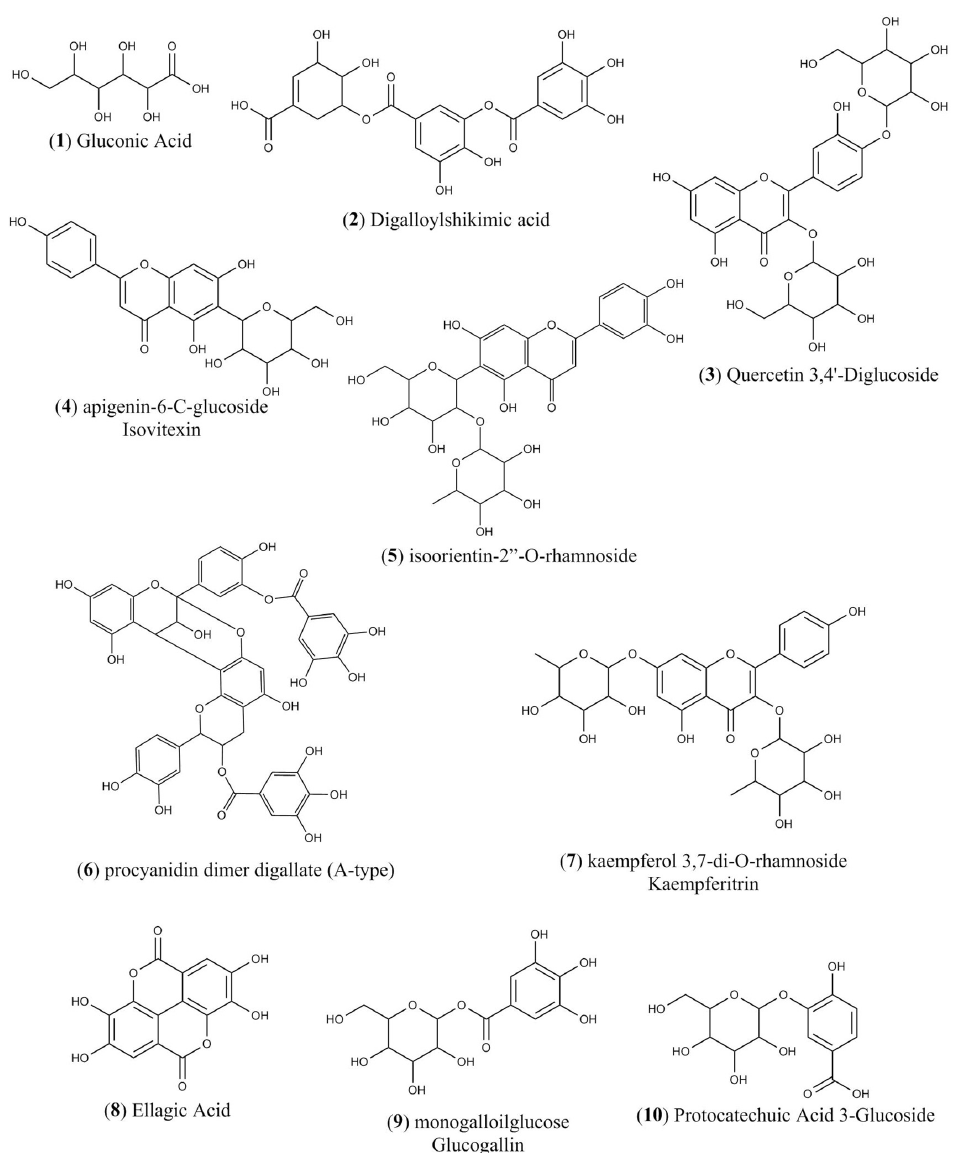
Figure 7. Chemical structures of the compounds identified by LC-ESI-IT-MS/MS in the hydroethanolic pollen extract collected by S. aff. postica from